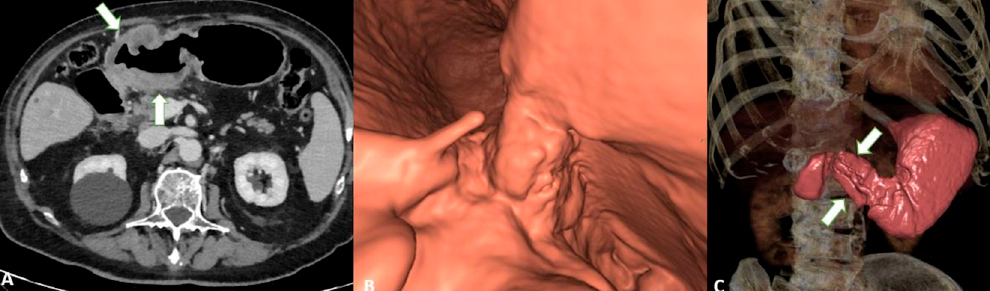
Figure 6. T4a gastric cancer in a 53-year-old female patient. ( A ) Axial 2D image in the portal venous phase with distension of the gastric lumen with air shows a bulky circumferential tumor (white arrows) of the low body of the stomach and of the gastric antrum with ulcerations; ( B ) Virtual gastroscopy delineates a lesion protruding in the lumen of the stomach; ( C ) Computed tomography gastrography shows a mucosal irregularity (white arrows) with a reduction of the lumen of the stomach.